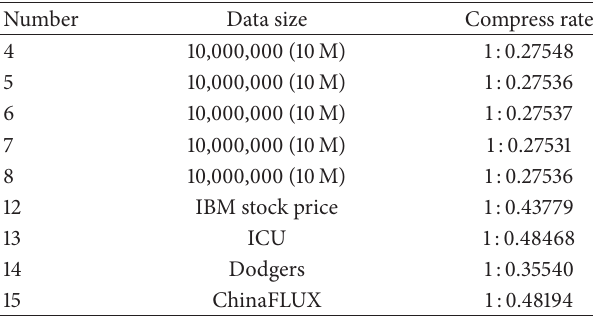
Figure 9: Relationship among efficiency, window size, and batch size. Table 4: Compress rate of